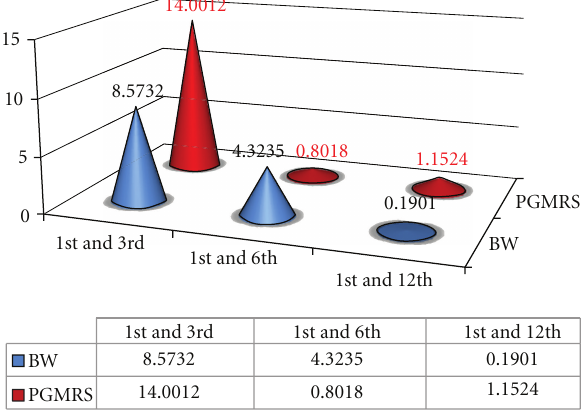
Figure 9: Comparison of tabulated values of biologic width (BW) and position of gingival margin from reference stent (PGMRS) with that of interweek intervals of Group B1.